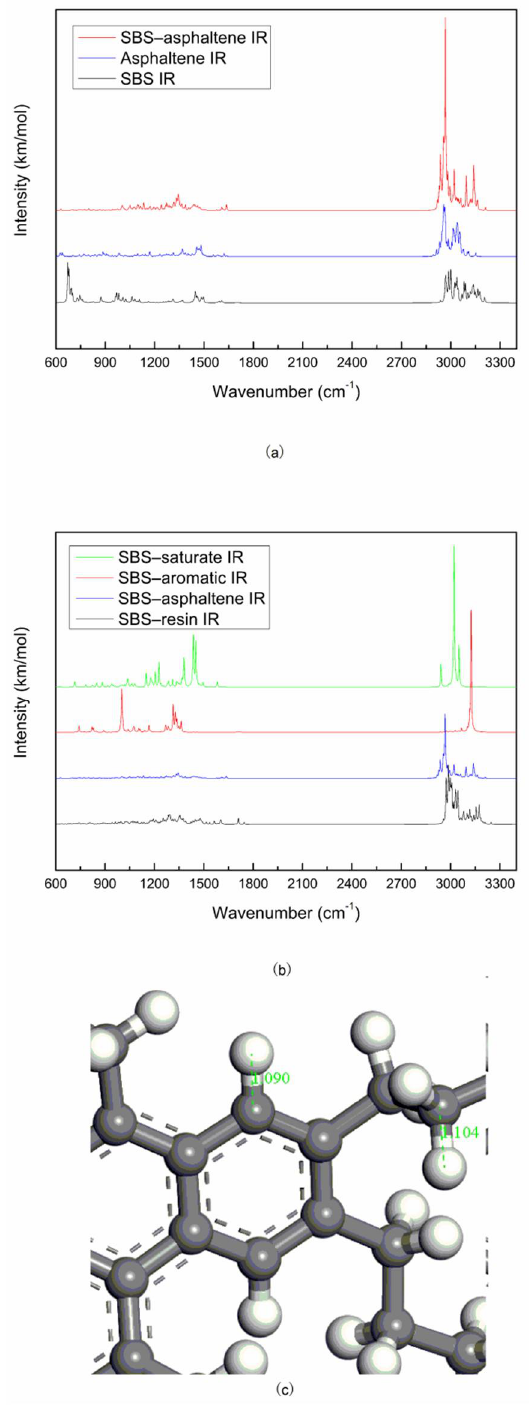
Figure 6. Molecular vibrational spectrums and bond length: ( a ) SBS IR, asphaltene IR, SBS–asphaltene IR; ( b ) SBS–resin IR, SBS–asphaltene IR, SBS–aromatic IR, SBS–saturate IR; ( c ) C–H bond length of asphaltene. Table 5. Assignations of the bands of the asphaltene molecule vibration spectrum.